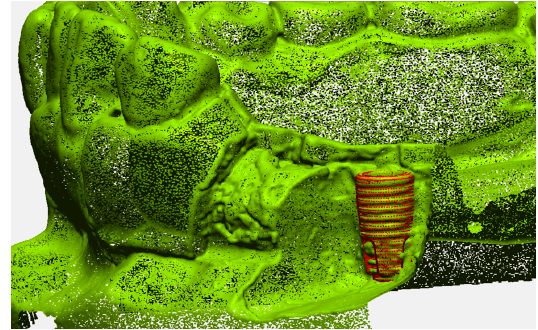
Figure 4. Reference image of the implant position.